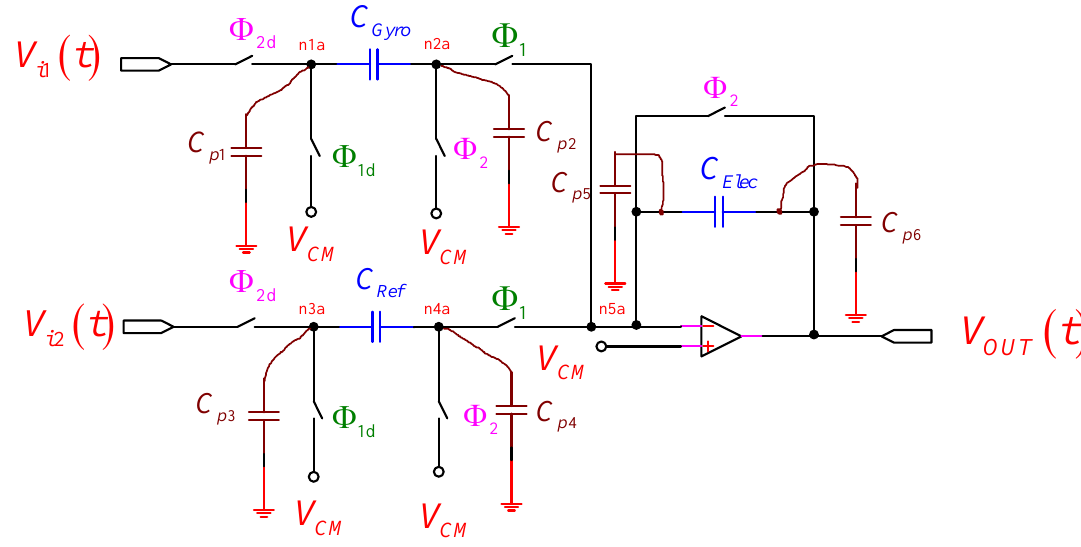
Figure 3. The PISC sensing circuit with parasitic capacitances